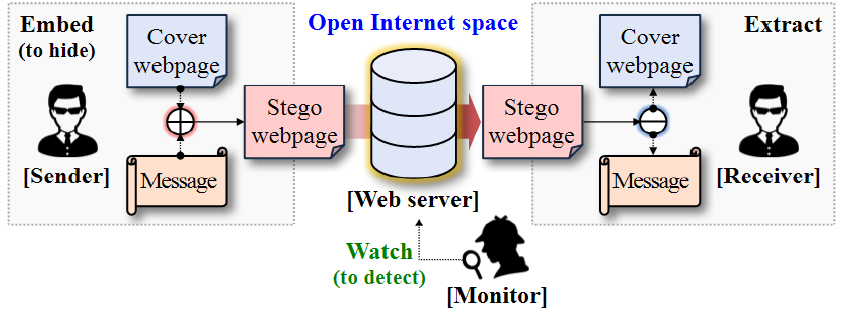
Figure 3. Webpage steganography-based covert communication model.